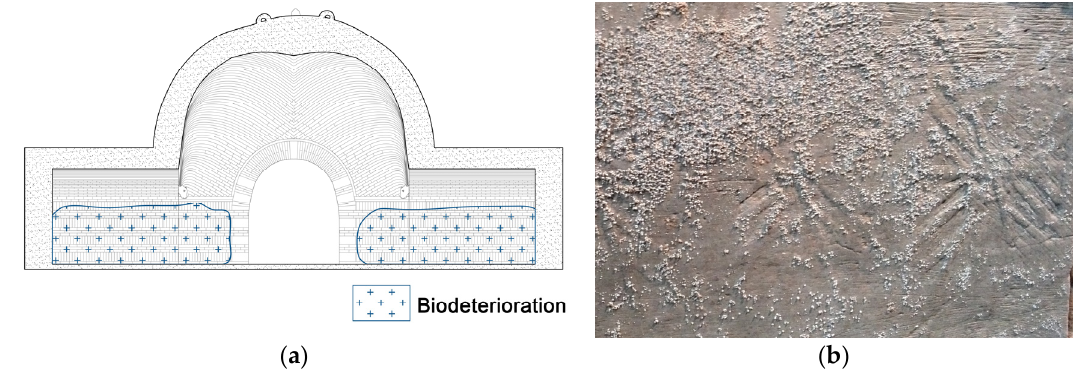
Figure 3. ( a ) Distribution of biodeterioration in Section 1-1 (Figure 2); ( b ) Biodeterioration detail.